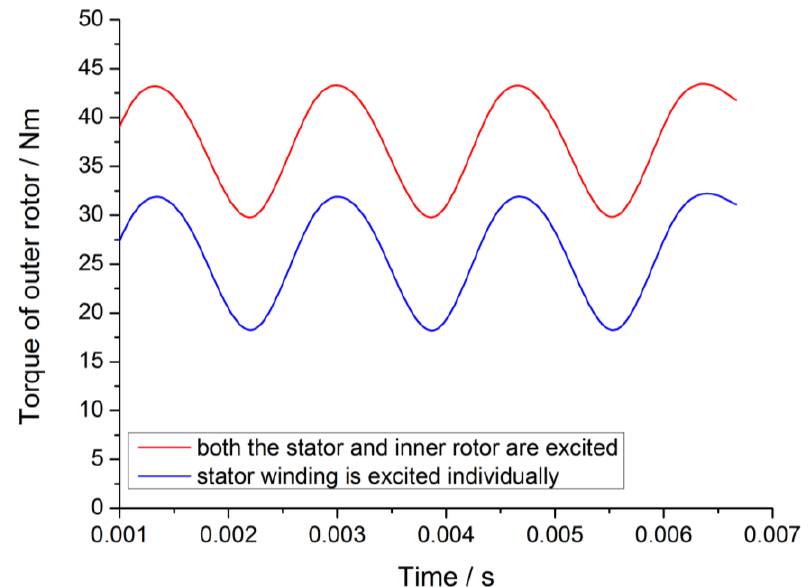
Figure 21. The torque waveforms of the outer rotor in different cases.